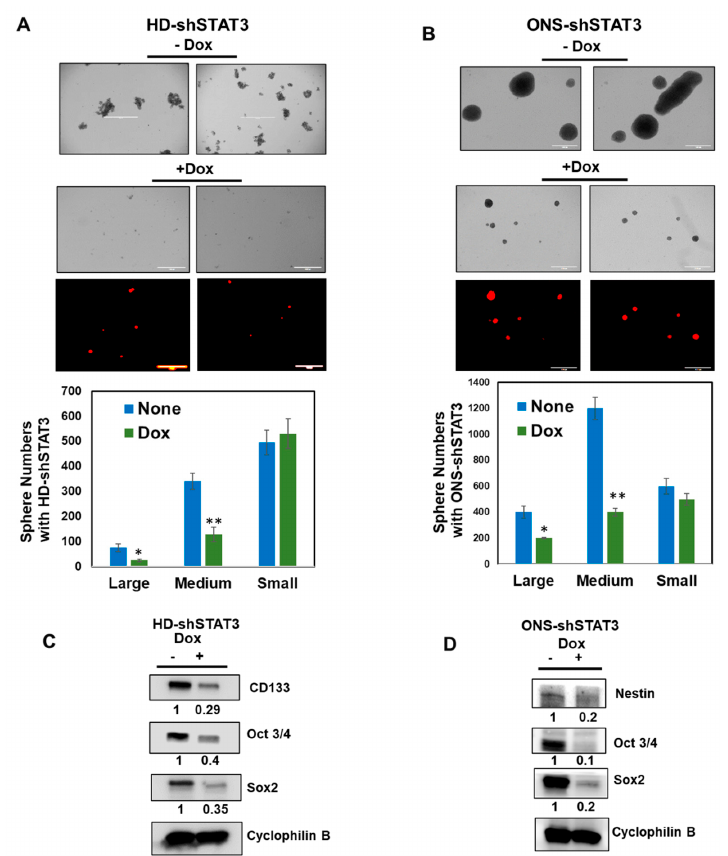
Figure 3. Effect of STAT3 KD on MB tumorsphere formation. ( A , B ) show representative morphologies of MB tumorspheres from HD-shSTAT3 and ONS-shSTAT3 MB cells grown in serum-free media in the presence and absence of 0.5 µ g/mL Dox. MB spheres with RFP expression in the presence of Dox are also shown (bottom). Small, medium and large spheres from the cells were enumerated and are shown below in the bar graph; * p < 0.05, ** p < 0.01. ( C , D ) show the expression of neural stem cell markers in the absence and presence of Dox in HD-shSTAT3 and ONS-shSTAT3 cells by Western immunoblot. Cyclophilin B acts as a loading control. The uncropped bolts are shown in Supplementary Materials file